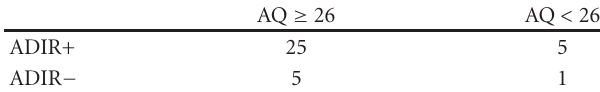
Table 2: The correlation between ADI-R and AQ.